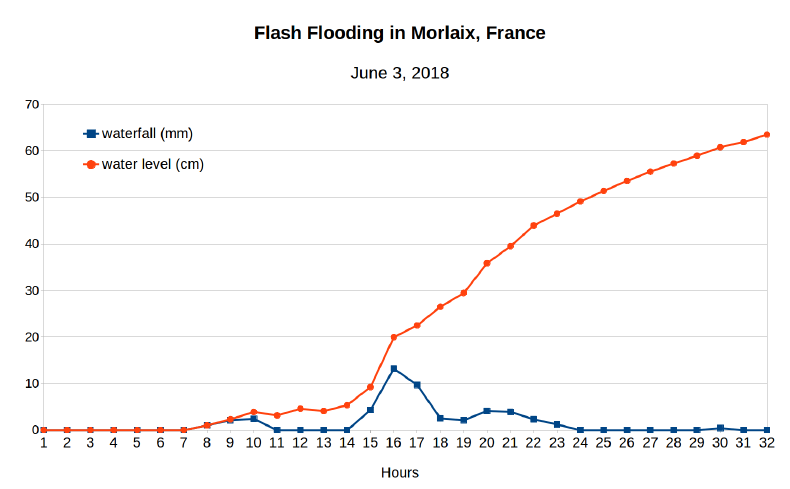
Figure A3. Chart shows rainfall levels over 32 h from 12:00 a.m. on 3 June 2018, to 8:00 a.m. on 4 June 2018. It was noticed that serious flooding often comes several hours after a storm or heavy rain. After the rain stopped, it required a couple of hours or days to drain all of the water.